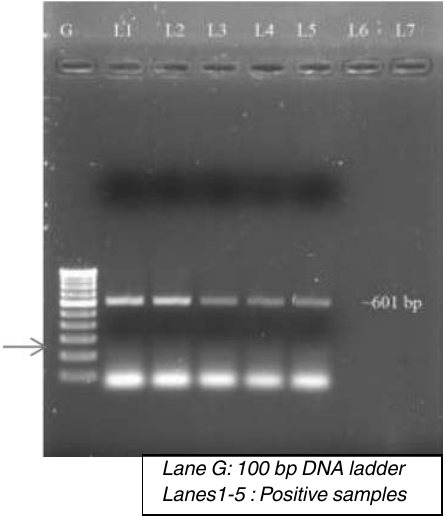
Lane G: 100 bp DNA ladder Lanes1-5 : Positive Fig. 2. Agarose gel (1.5 %) electrophoresis of PCR products of Theileria orientalis